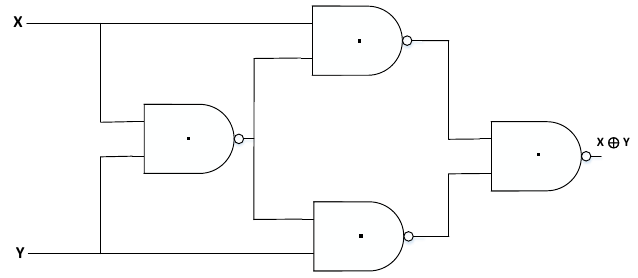
Figure 7. CNTFET-RRAM ternary Ex-OR